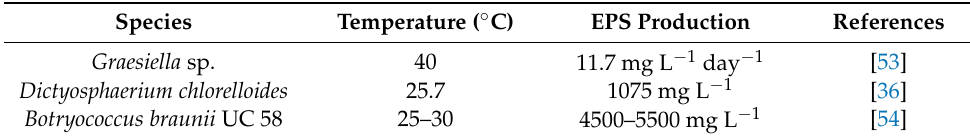
Table 3. Effect of temperature on EPS